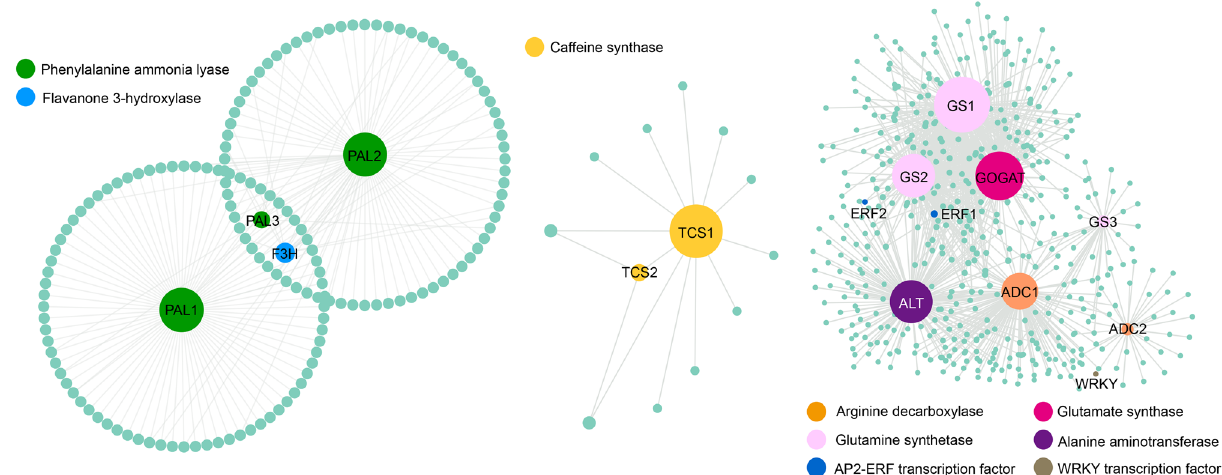
Figure 7. Co-expression network of DEGs related to taste compound biosynthesis in tea plants. The size and color of the circle represent the number of edges and different genes, respectively. This image was generated by Cytoscape software 38 (v3.6.0, https:// cytos cape.